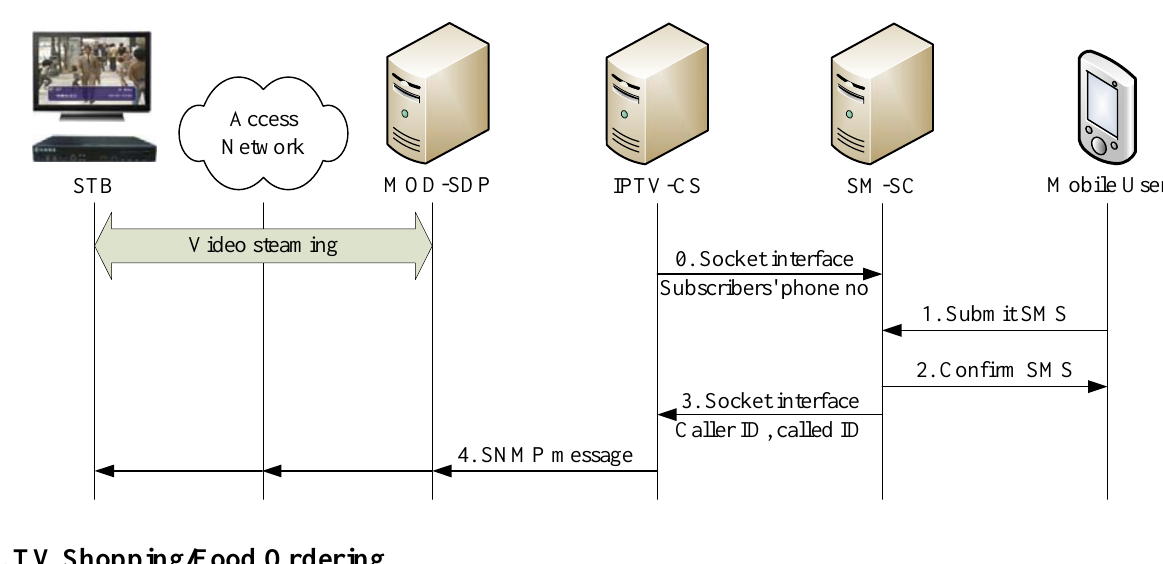
Figure 7. Message flow of SMS on TV